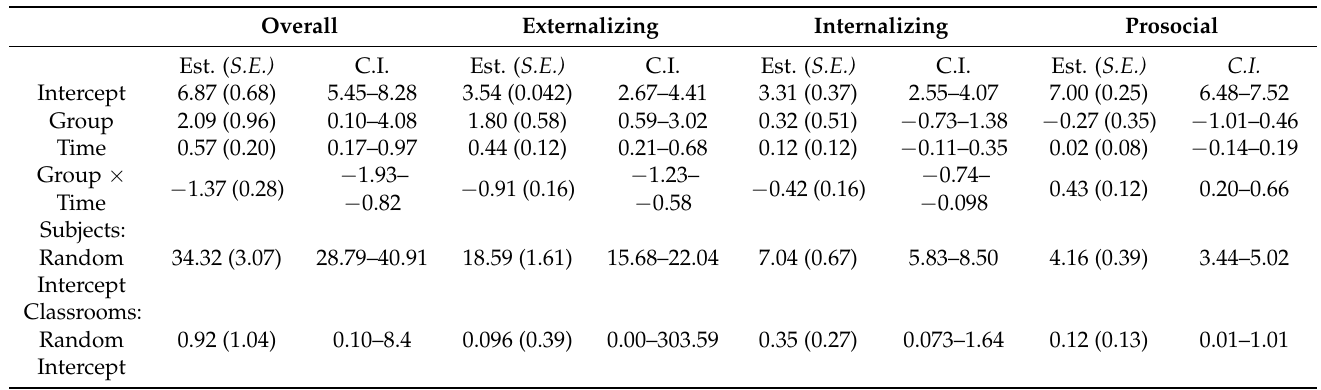
Table 2. Mixed models predicting changes in the SDQ